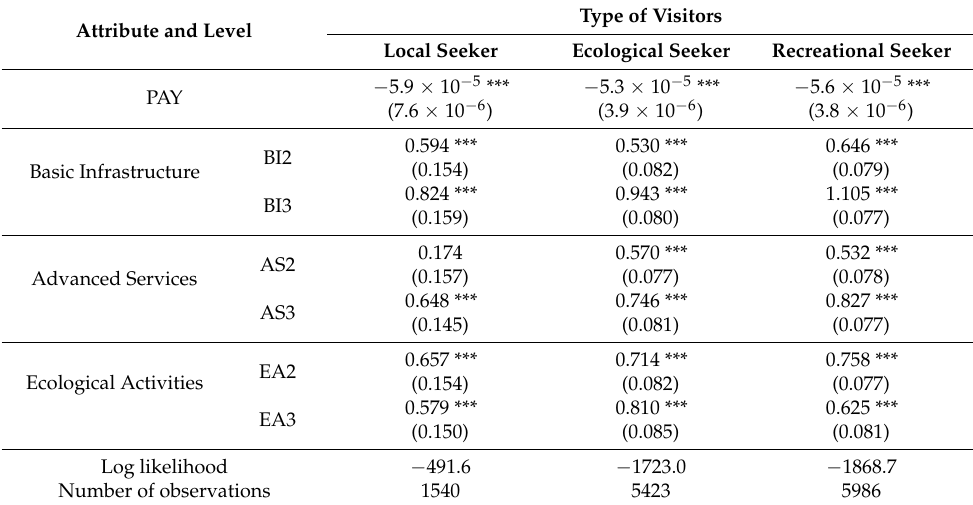
Table 7. Estimated results by type of